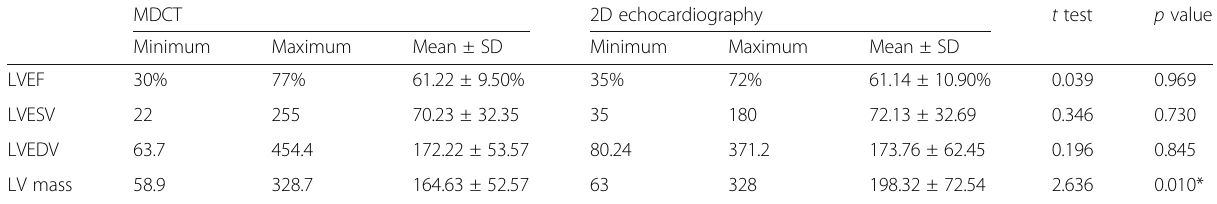
Table 2 Comparison between MDCT and 2D echocardiography regarding LV ejection fraction, LV end-systolic volume, LV end- diastolic volume, and LV mass MDCT